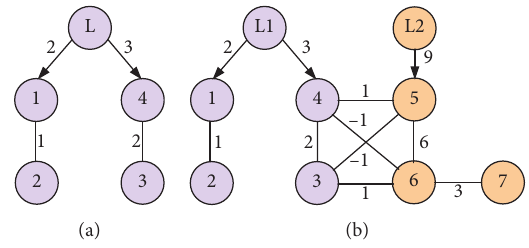
Figure 2: Interaction topologies of Example 1 (a) and Example